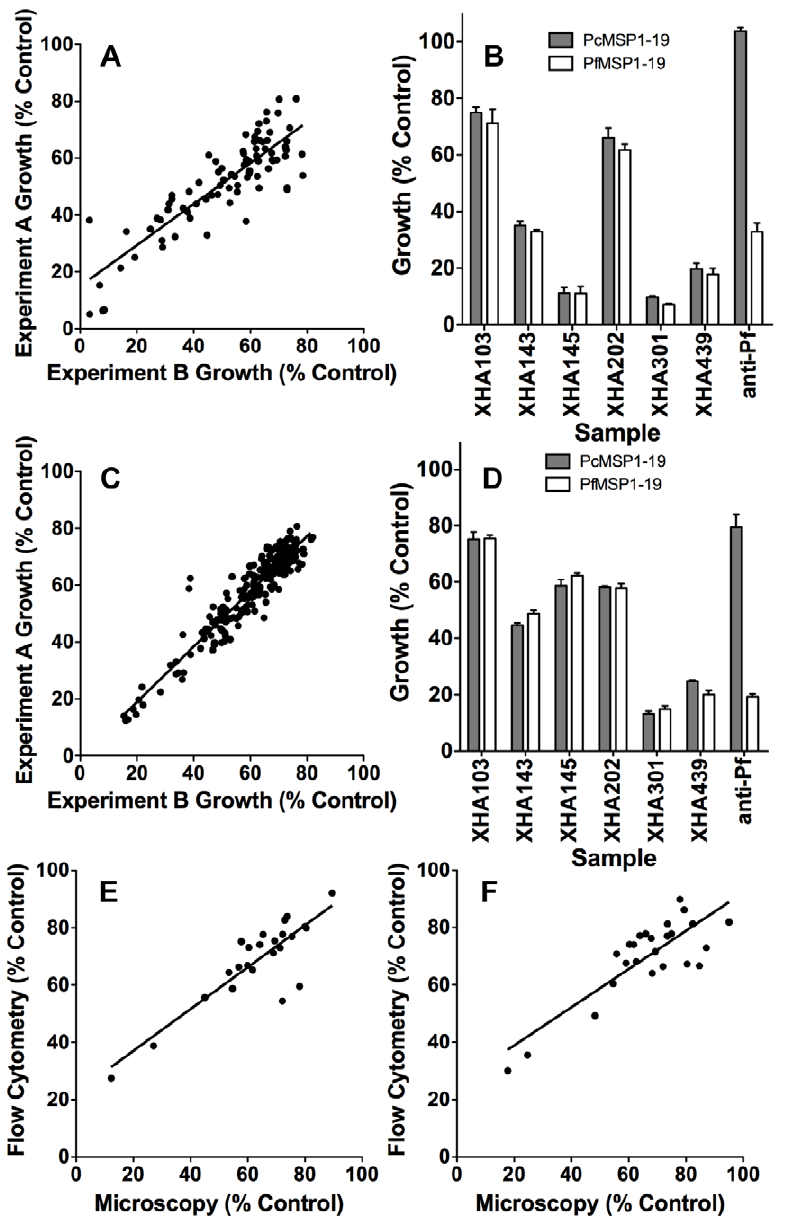
Figure 3. Reproducibility of PfMSP1-19 specific growth inhibition assays and levels of PfMSP1-19 specific inhibition for representative samples. ( A ) Correlation of PfMSP1-19 line growth between duplicate experiments for 85 samples of the non-dialysed Mugil plasma samples showing a high level of assay reproducibility (r s =0.88, n=85, P , 0.0001). ( B ) Subset of non-dialysed Mugil plasma samples showing total growth inhibitory activity but little or no PfMSP1-19 specific inhibitory activity in 2 cycle assays. Confirmation that the assay was able to measure PfMSP1-19 specific inhibition was provided through the use of inhibitory rabbit antisera raised against PfMSP1-19 (anti-Pf). ( C ) Correlation of PfMSP1- 19 line growth between duplicate experiments for dialysed Mugil plasma samples showing a high level of assay reproducibility (r s =0.93, n=204, P , 0.0001). ( D ) Subset of dialysed Mugil plasma showing total growth inhibitory activity but little or no PfMSP1-19 specific inhibitory activity in 2 cycle assays. Correlation between parasite growth measured in flow cytometry or microscopy based 1 cycle assays for ( E ) the PcMSP1-19 line (r s =0.72, n=25, P , 0.0001) and ( F ) the PfMSP1-19 line (r s =0.59, n=25, P=0.0018) highlight comparable levels of growth between the two methods. Parasite growth was expressed as a percentage of the mean growth of a panel of non-dialysed or dialysed Melbourne control sera included on each assay plate. immunoglobulins. In duplicate experiments, only a low level of PfMSP1-19 specific inhibitory activity was detected for the